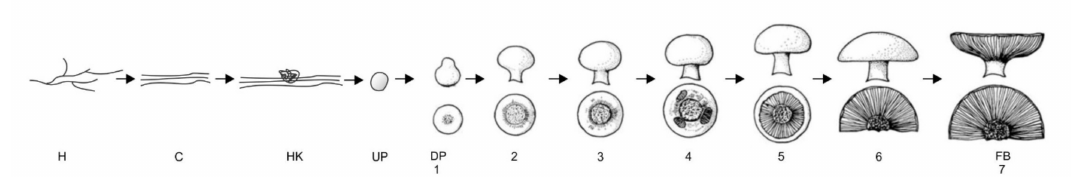
Figure 1. Main stages in the development of a Fruiting body (FB) from hyphae (H). The intermediate stages are cords (C), Hyphal knots (HK), undi ff erentiated primordia (UP) and from di ff erentiated primordia (DP) to Fruiting bodies (FP) in 7 stages (adapted from Hammond and Nichols [19]). Especially the very early stages are di ffi cult to study in casing soil due to their microscopically small